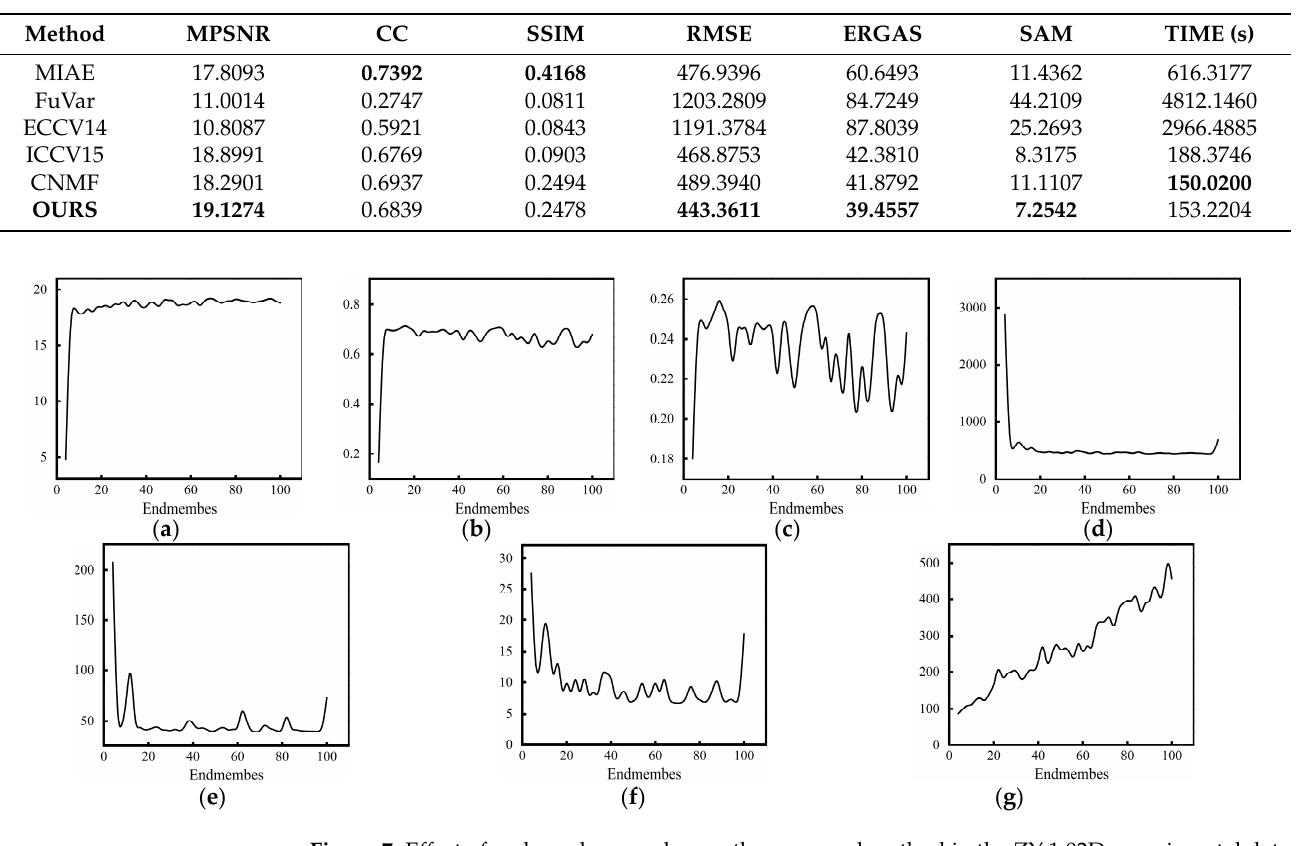
Table 3. Quantitative indices of SRR in ZY-1 02D HSI.